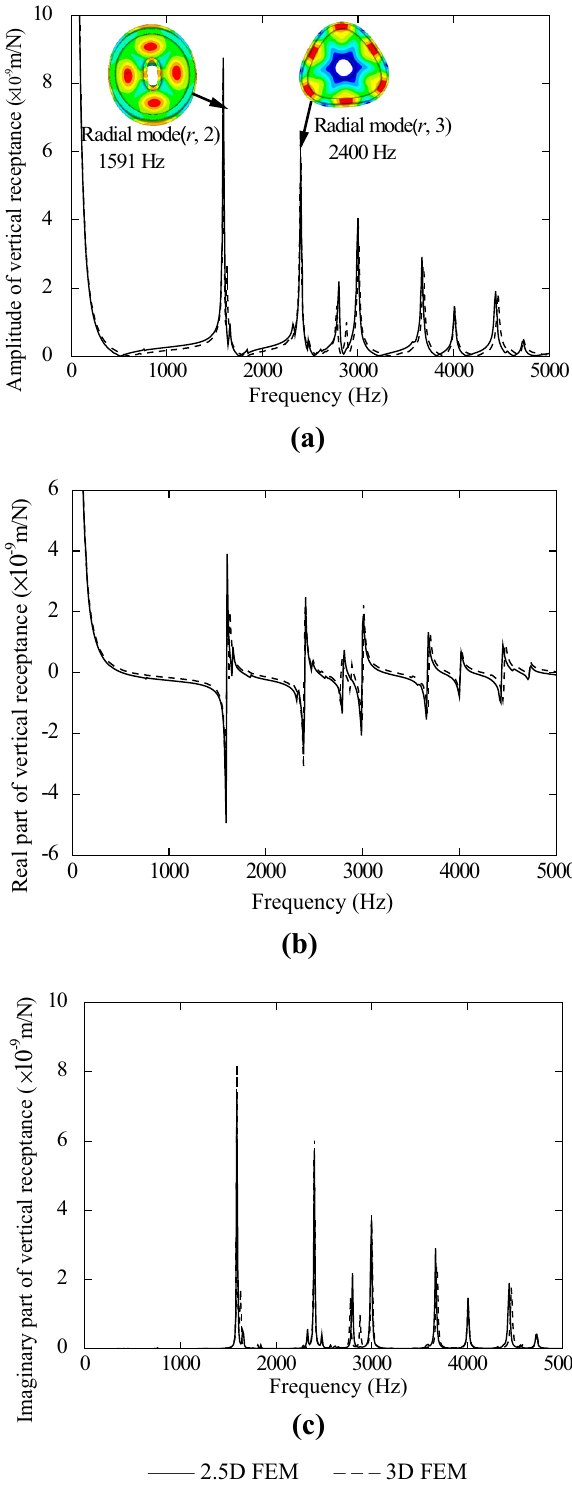
Fig. 5 Comparison in the vertical receptance of the wheel at the wheel–rail contact point. a Amplitude, b real part, c imaginary